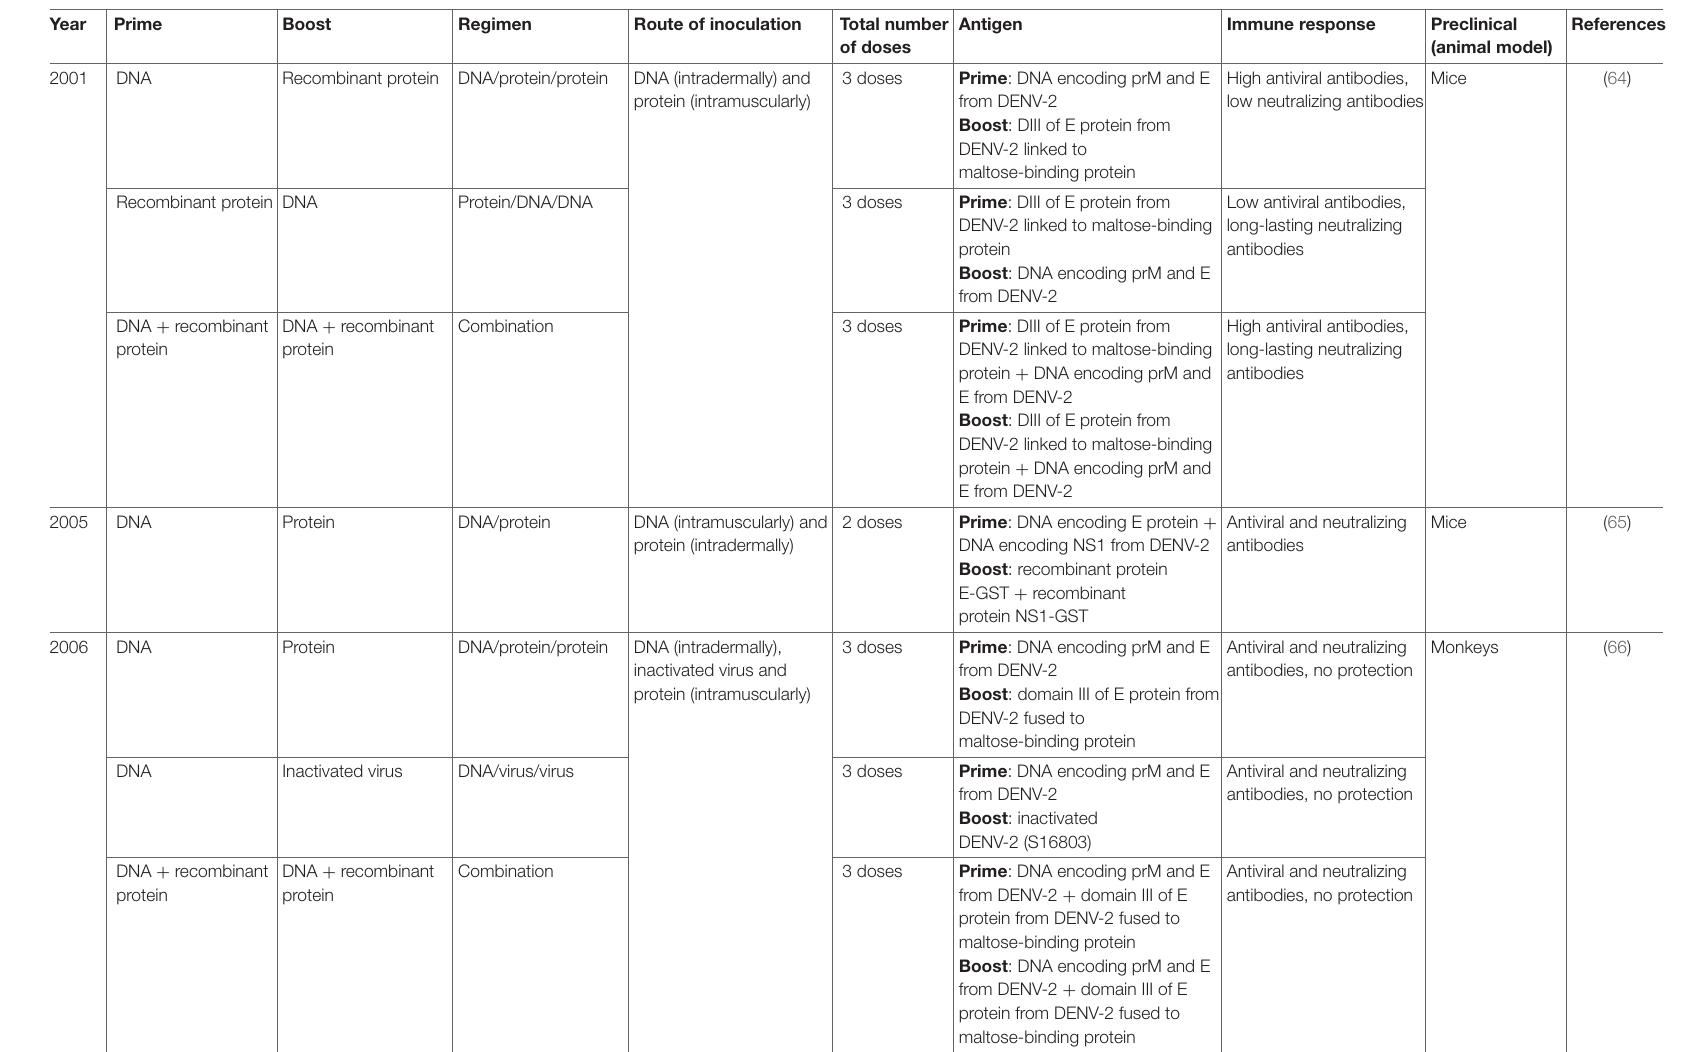
TABLE 1 | Prime-boost strategies used in preclinical studies to develop dengue